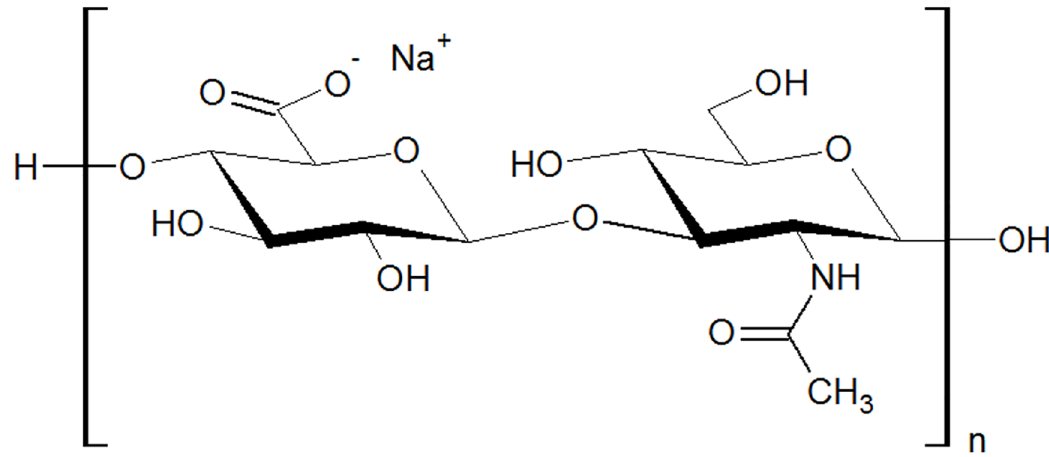
Fig 1. Structure of hyaluronan